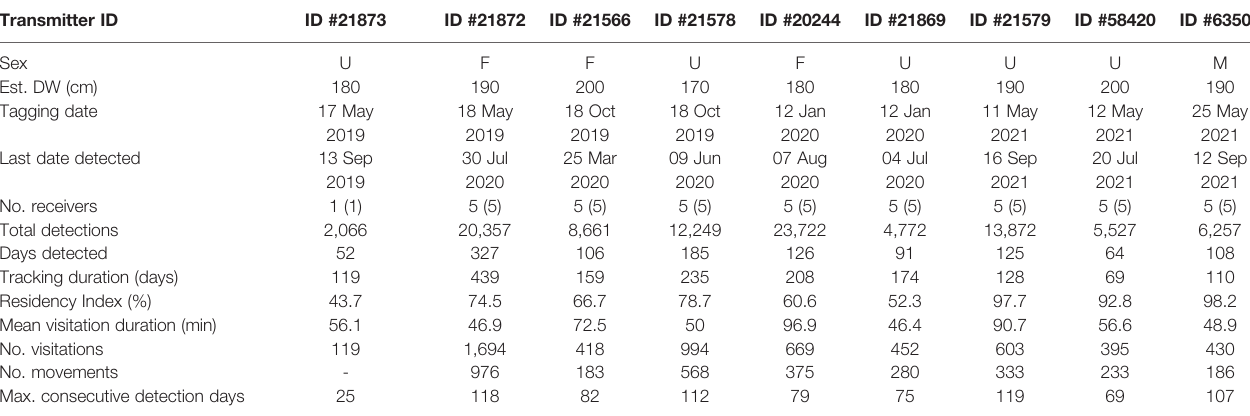
TABLE 2 | Summary details for the nine juvenile M. alfredi tracked within the Wayag lagoon using passive acoustic telemetry. Transmitter